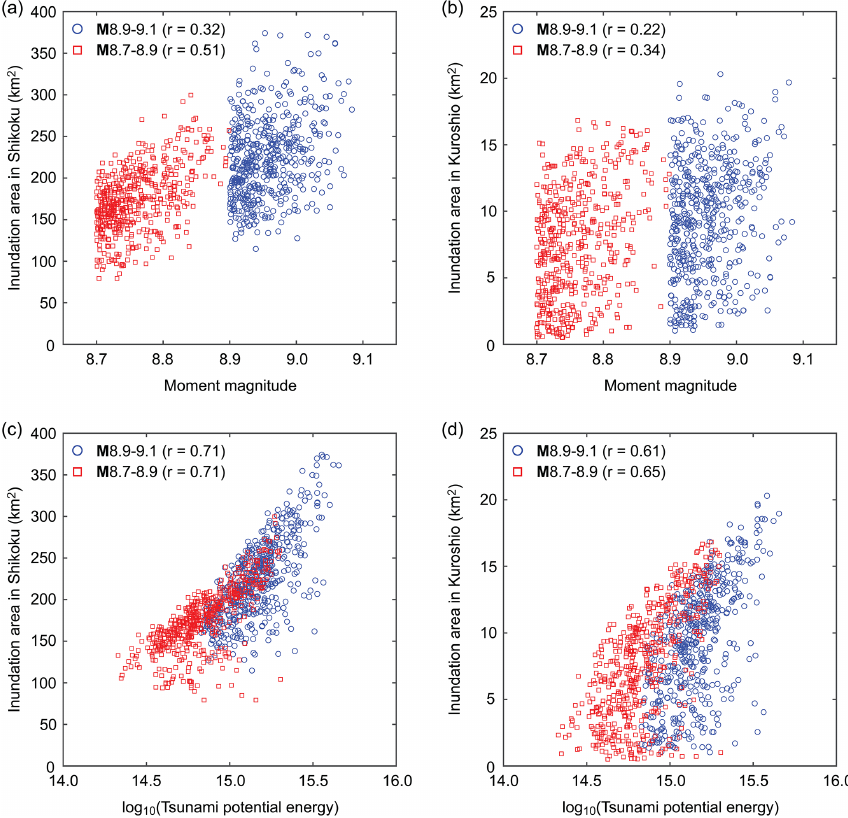
Figure 10. Scatter plots of moment magnitude versus tsunami inundation area in Shikoku and Kuroshio for the two magnitude ranges M 8.9– 9.1 (a) and M 8.7–8.9 (b) . Scatter plots of tsunami potential energy versus tsunami inundation area in Shikoku and Kuroshio for the two magnitude ranges M 8.9–9.1 (c) and M 8.7–8.9 (d)